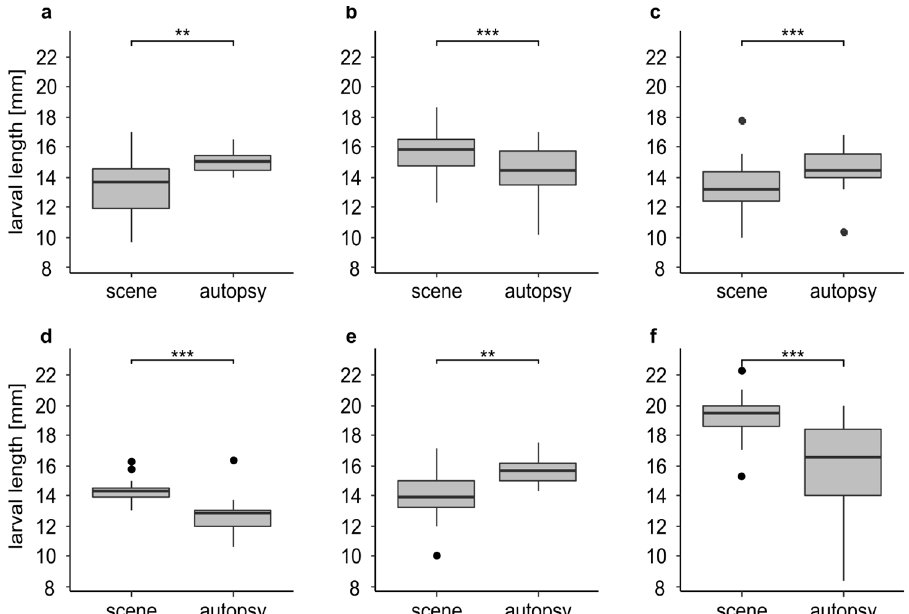
Figure 4. Larval length in mm for insect samples from the scene and the autopsy (n-values = identical for the scene and the autopsy; ( a ) larvae of L. sericata (n = 20) from case 3 after 0 and 8 days of cooling; ( b ) larvae of L. sericata (n = 60) from case 5 after 0 and 8 days of cooling; ( c ) larvae of L. sericata (n = 44) from case 23 after 0 and 5 days of cooling; ( d ) larvae of L. sericata (n = 13) from case 24 after 0 and 4 days of cooling; ( e ) larvae of L. sericata (n = 14) from case 27 after 0 and 8 days of cooling; ( f ) larvae of C. vicina (n = 50) from case 1 after 0 and 5 days of cooling. The asterisks representing p -values with *** < 0.001, ** < 0.01.